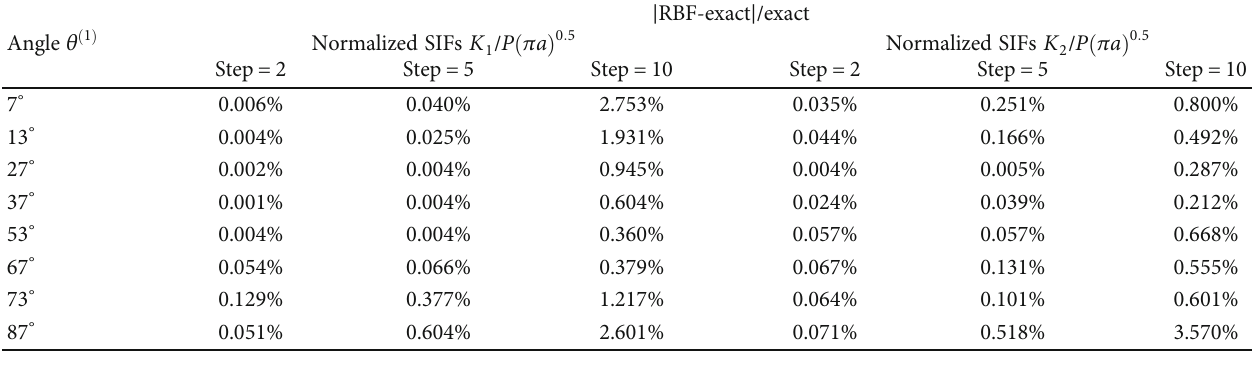
Table 2: Relative error table of approximate value and numerical solution under di ff erent interpolation steps.